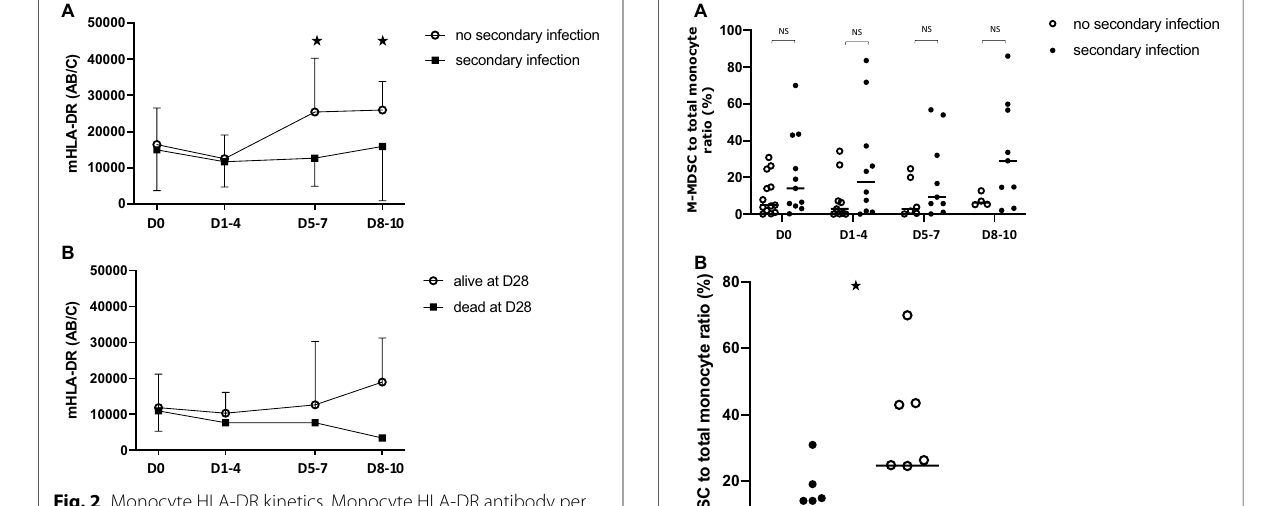
Fig. 2 Monocyte HLA‑DR kinetics. Monocyte HLA‑DR antibody per cell surface expression from admission to day 8–10 in patients with secondary infection ( a ) or survivors at day 28 ( b ). * p < 0.05